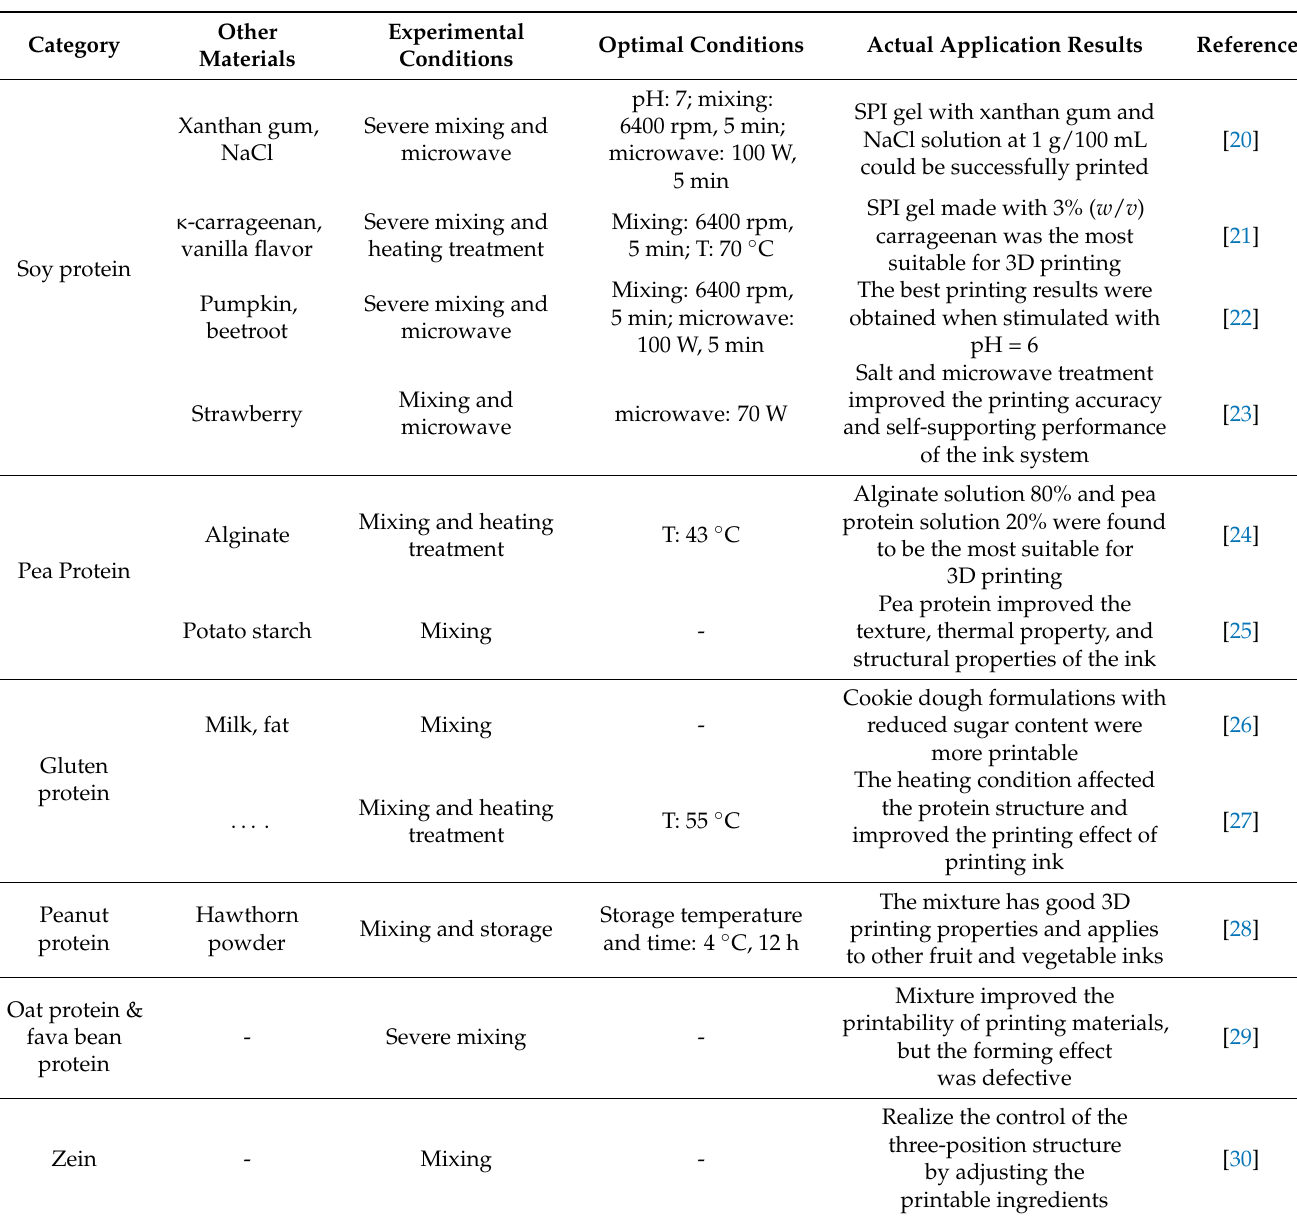
Table 2. Plant-protein-based printing